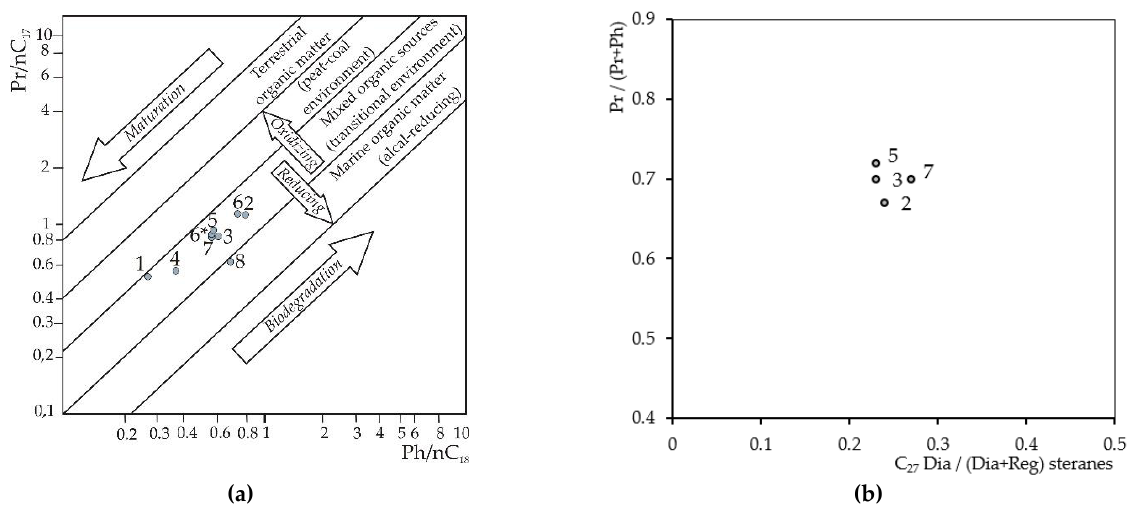
Figure 9. Pr/ n- C17 ratio vs. Ph/ n- C18 ratio ( a ) and pristane/(pristane+phytane) ratio vs. C 27 steranes Dia/(Dia+Reg) ratio ( b ) for thermal extracts of the rocks from the members #1 to #8 (thermal extraction at 350 °C).